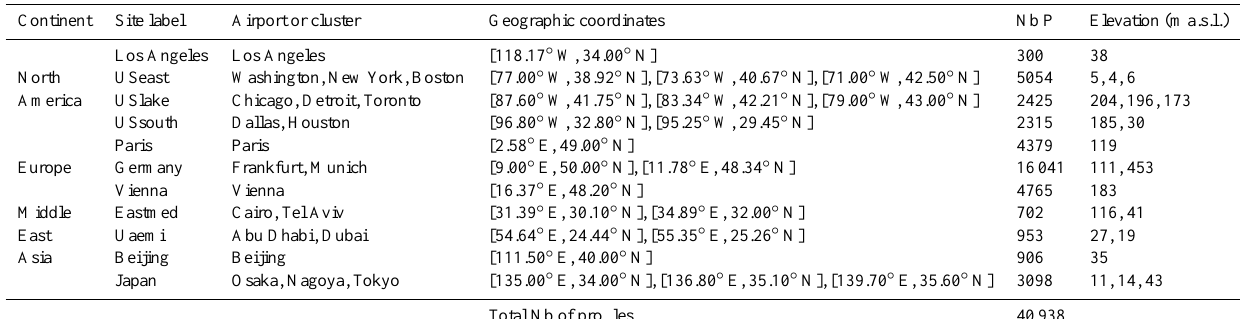
Table 1. Geographical context of the study over four continents (column 1) with the MOZAIC site labelling (column 2), the related airport or airports for a cluster (column 3), the airport geographic coordinates (column 4), the number of associated MOZAIC profiles (Nb P, column 5), the airport elevation (column 6) and total number of MOZAIC profiles included in this study (bottom line). Continent Site